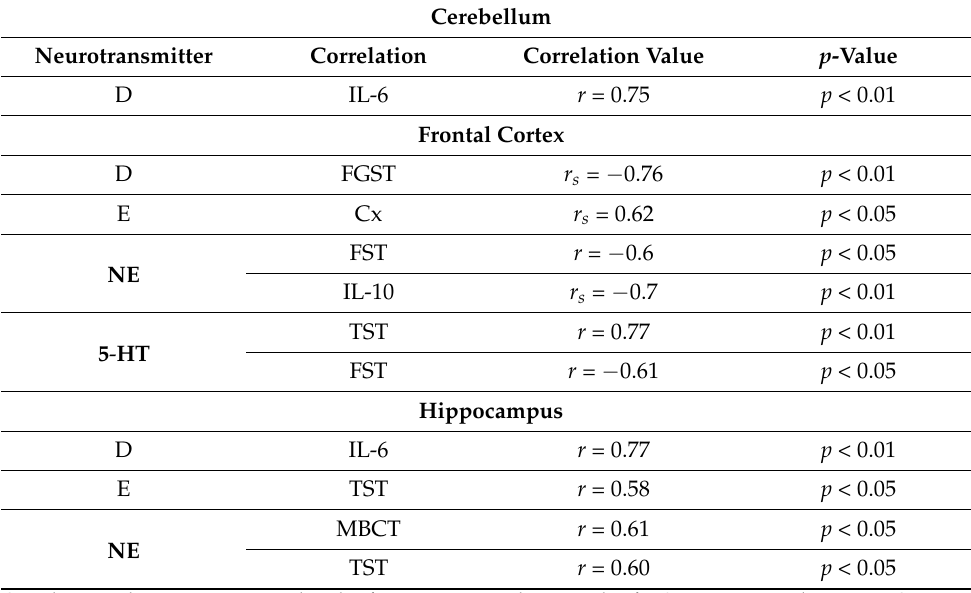
Table 3. Correlative analyses among parametrized variables in infected mice at day 21-PI.